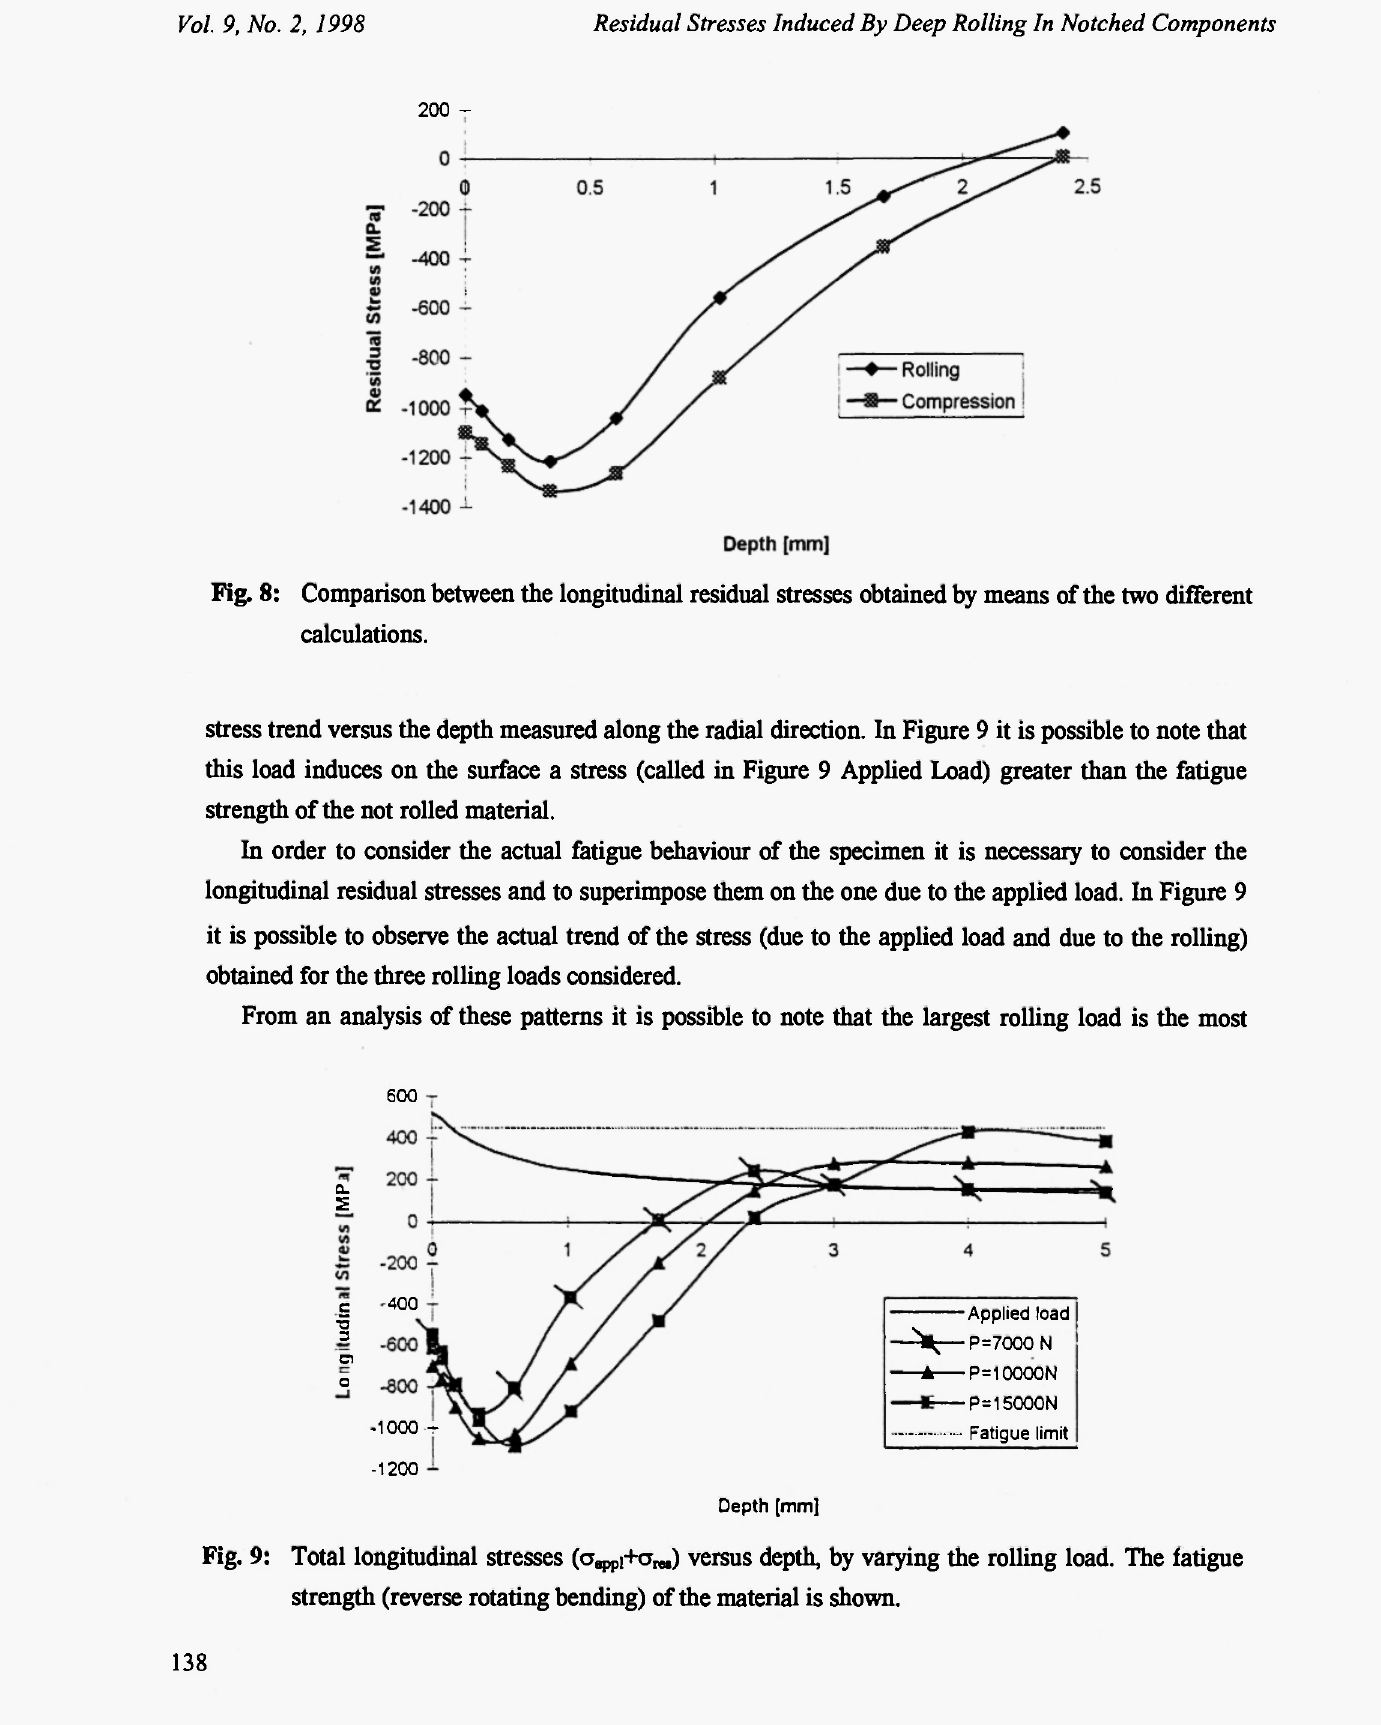
Fig. 9: Total longitudinal stresses (σ^ι+σ™) versus depth, by varying the rolling load. The fatigue strength (reverse rotating bending) of the material is